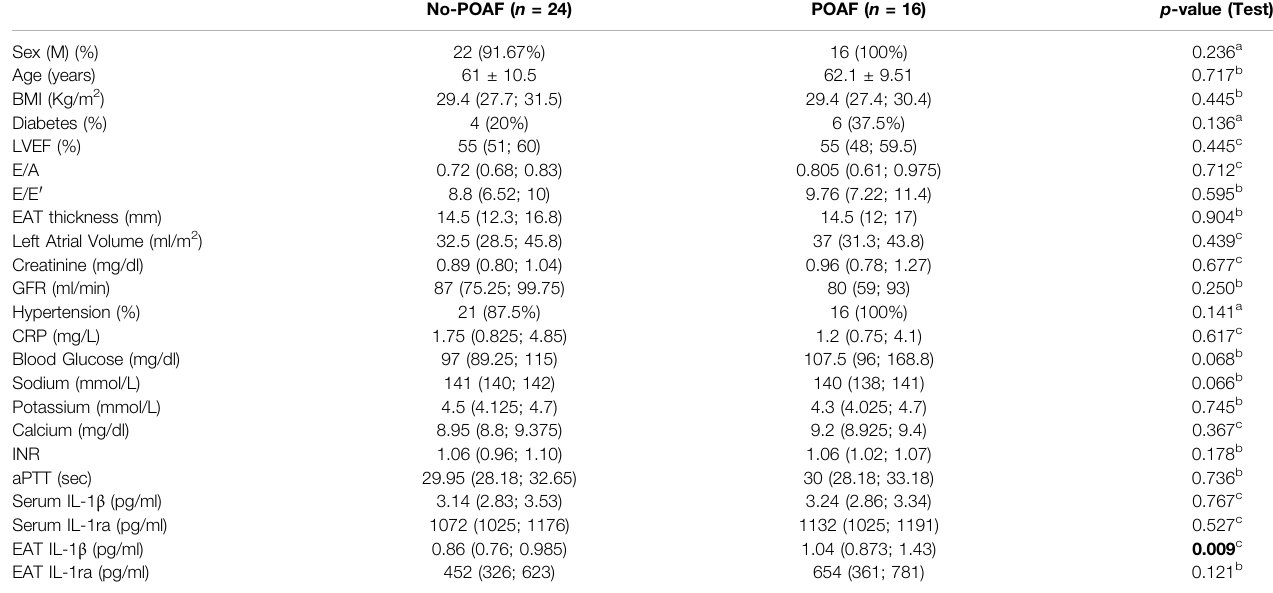
TABLE 1 | Patient clinical characteristics in No-POAF and POAF groups.